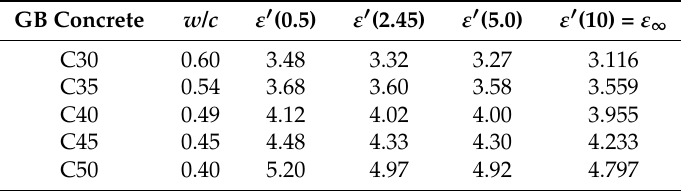
Table 7. Calculated dielectric constant at 0.5, 2.45, and 5.0 GHz using the Jonscher model, Equation (7).